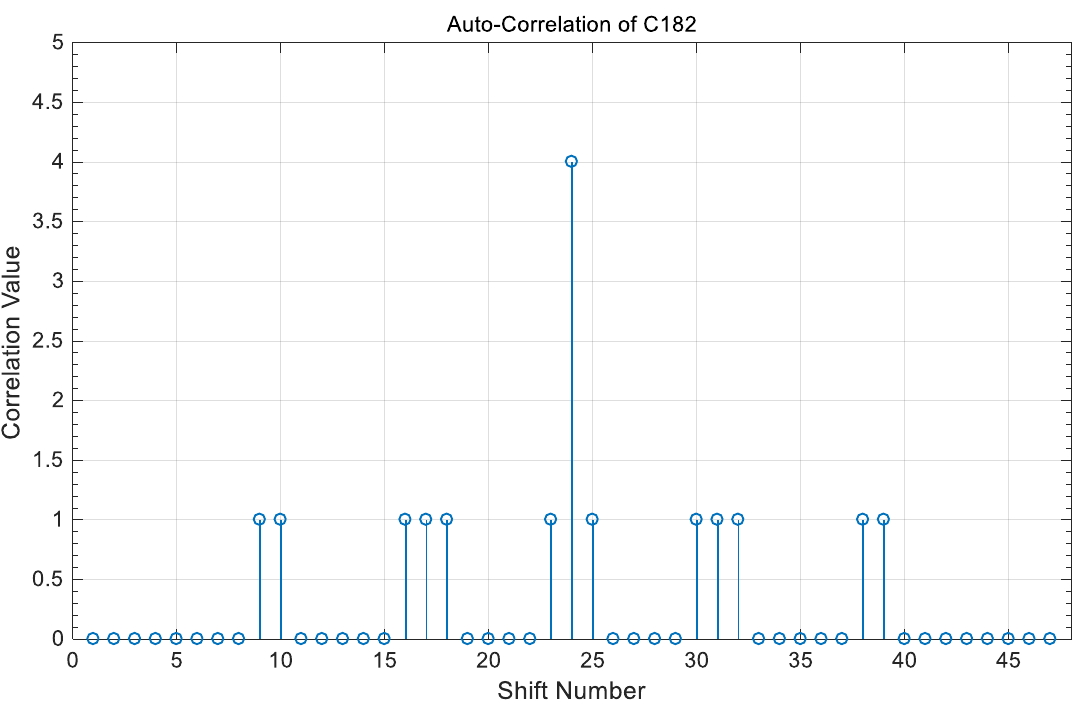
Figure 7. Auto-correlation of 𝐶 182 sequence, 𝑃 1 = 5 and 𝑃 2 = 7.